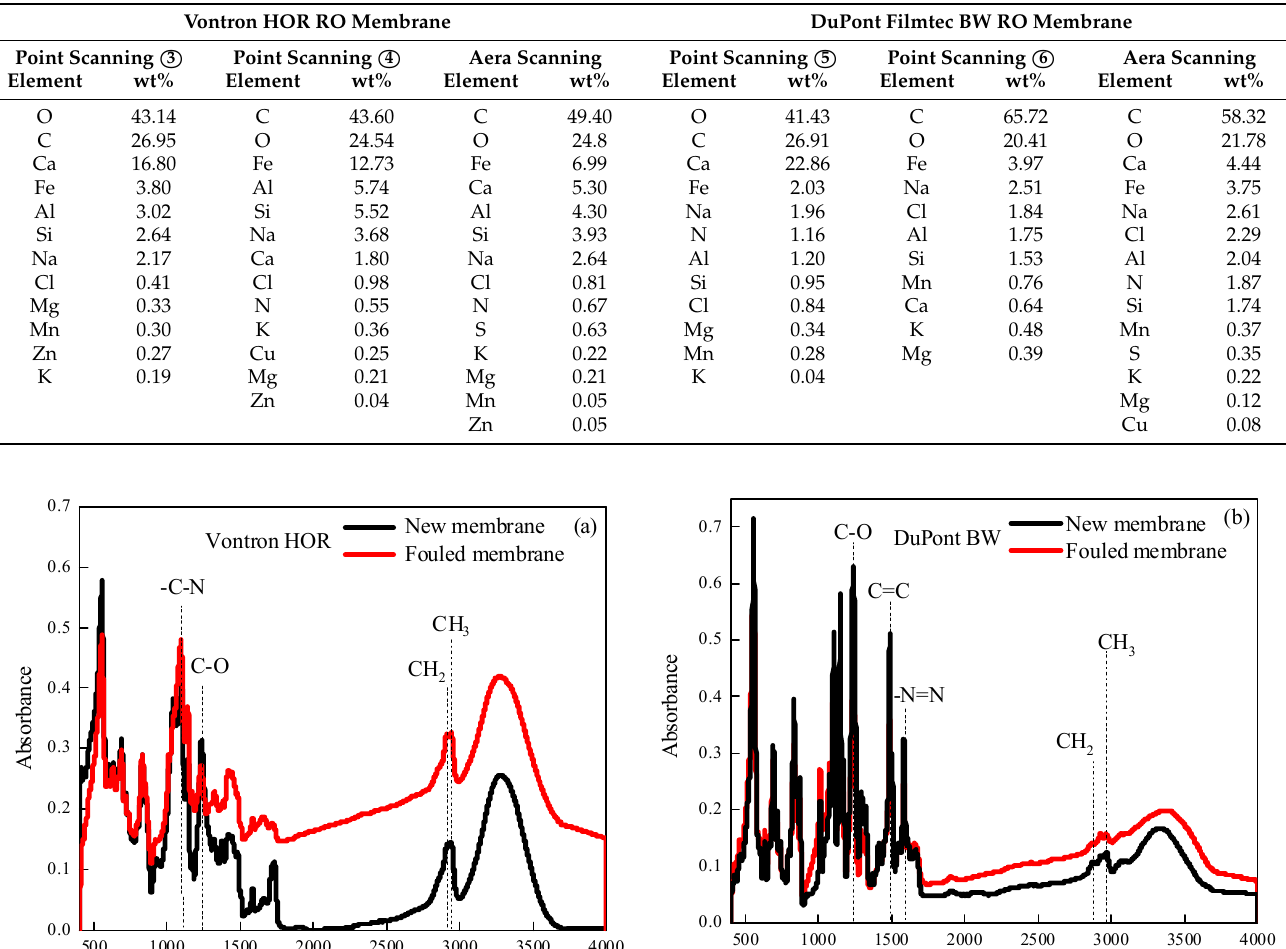
Table 4. Elemental composition of foulants on candidate RO membranes via EDS.